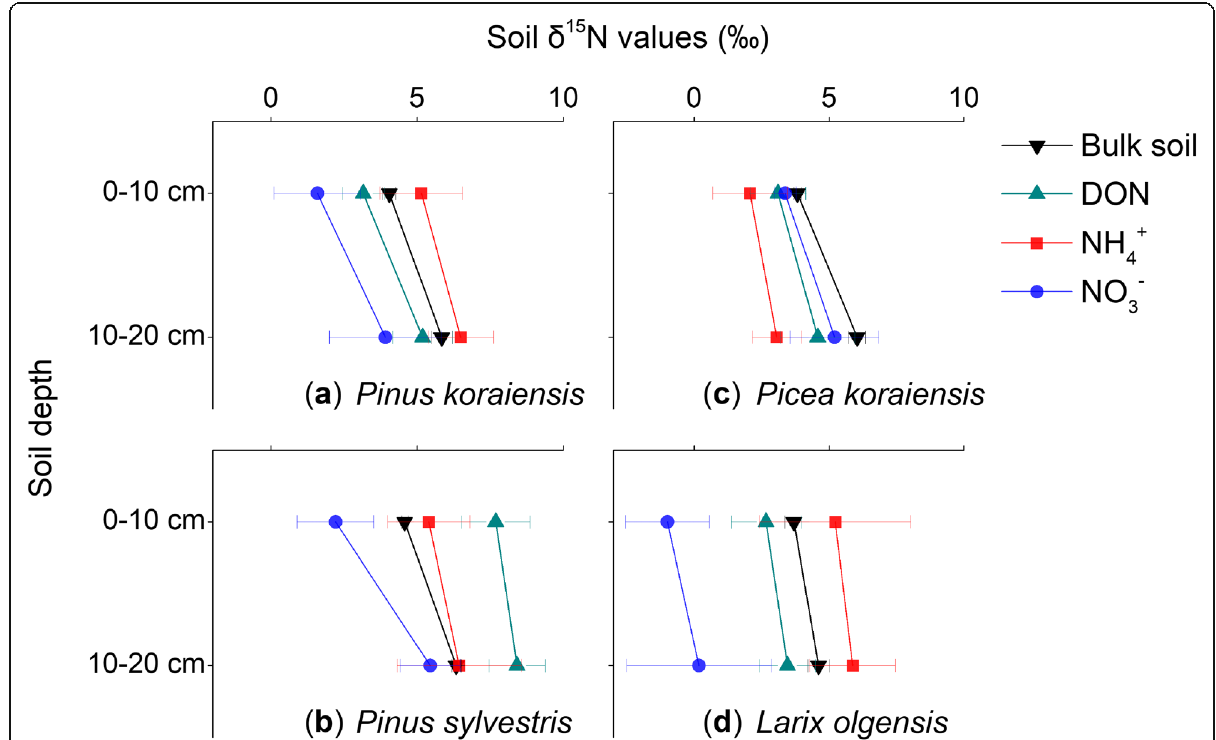
Fig. 2 Soil δ 15 N values in the 0 – 10 cm and 10 – 20 cm mineral soil of the four studied forest plantations (means ± SE, n = 5)